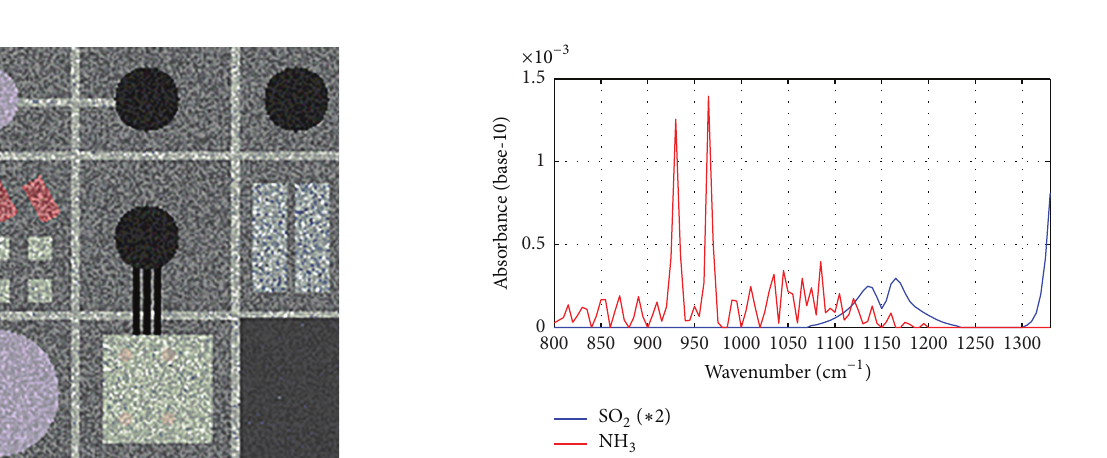
Figure 3: Synthetic refinery scene without plume. Image in RGB colors, representing the bands (R: 820 cm −1 , G: 965 cm −1 , and B: 1165 cm −1 ).